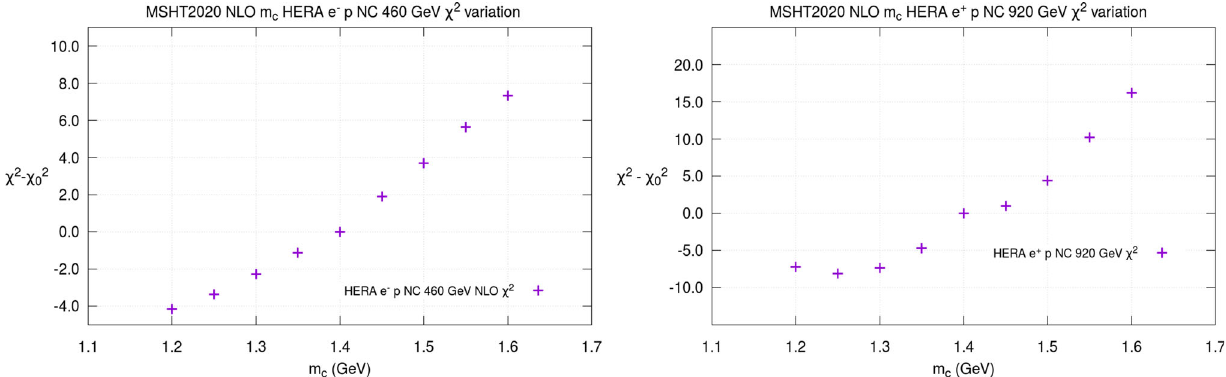
) = 0 . 118 for (left) the total reduced cross section ˜ σ for the combined H1 Z